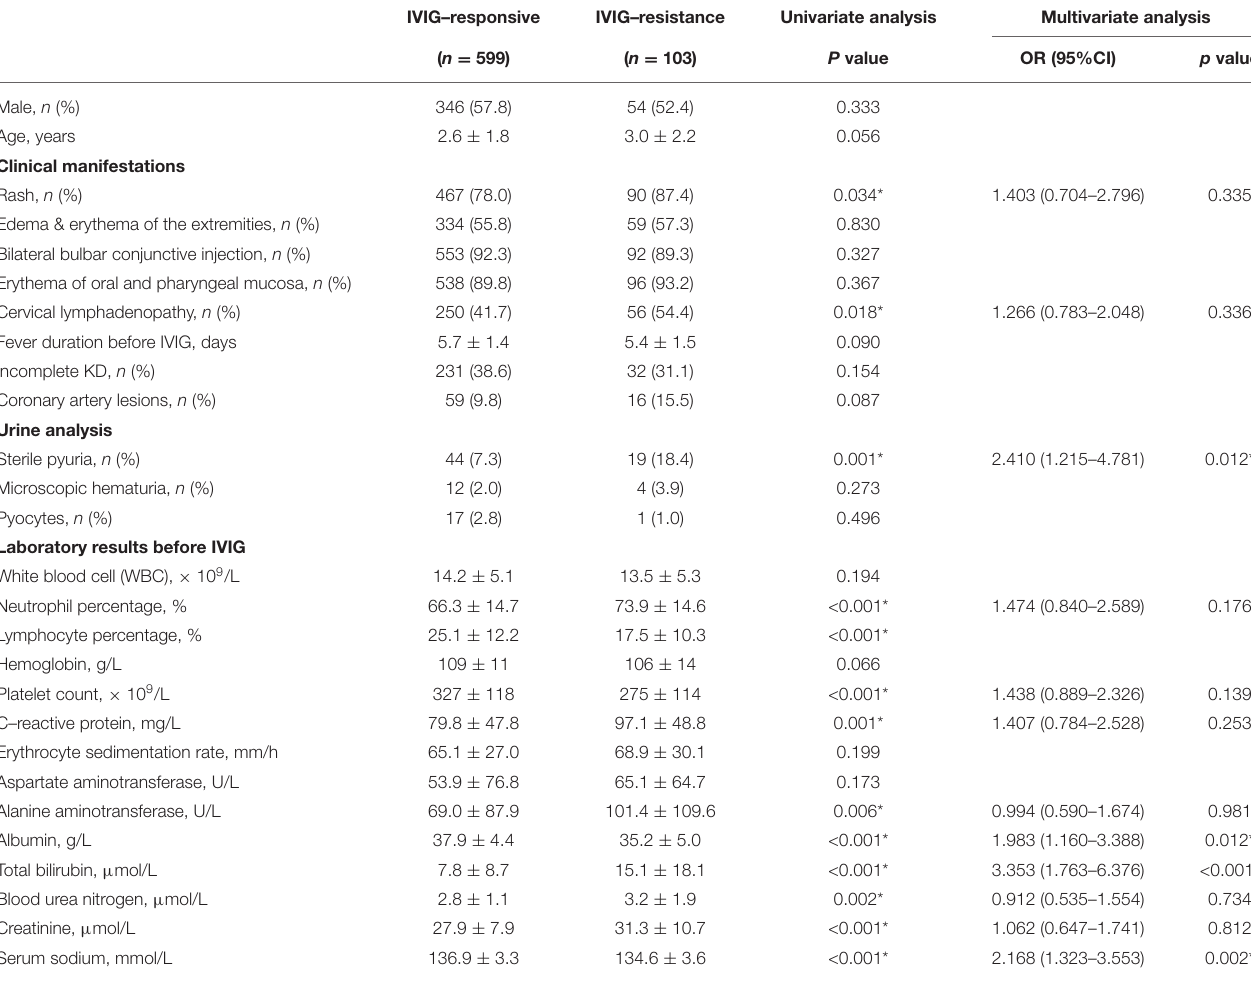
TABLE 3 | Comparison of clinical data between the groups of IVIG-response and IVIG-resistance in patients with Kawasaki